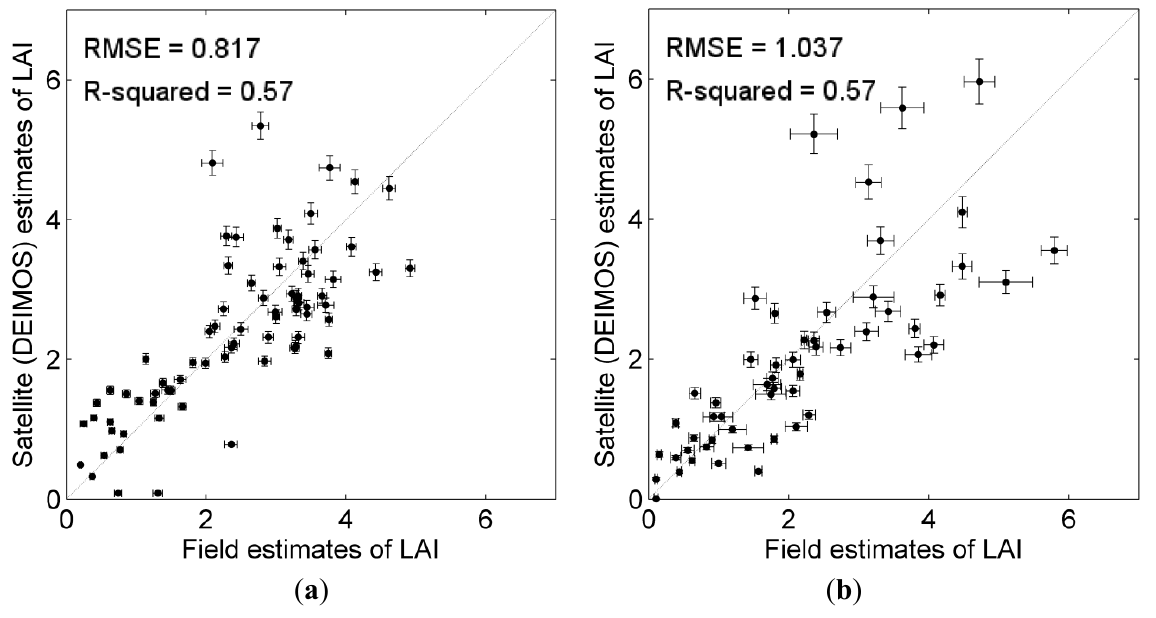
Figure 3. Procedure 1: scatterplots of the LAI estimation for the Italian case study ( a ) and for the Austria case study ( b ). Vertical error bars correspond to the Standard Error on LAI (SEL) measurements for each ESU. Horizontal error bars correspond to the Standard Error on LAI predictions and it was estimated using resampling with 200 bootstraps.